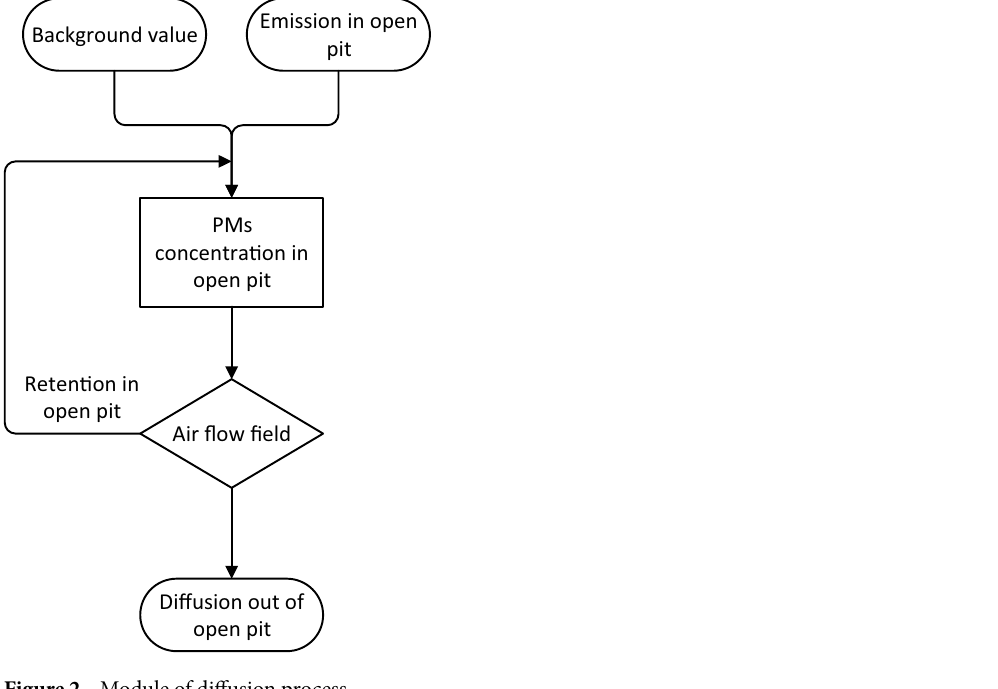
Figure 2. Module of diffusion